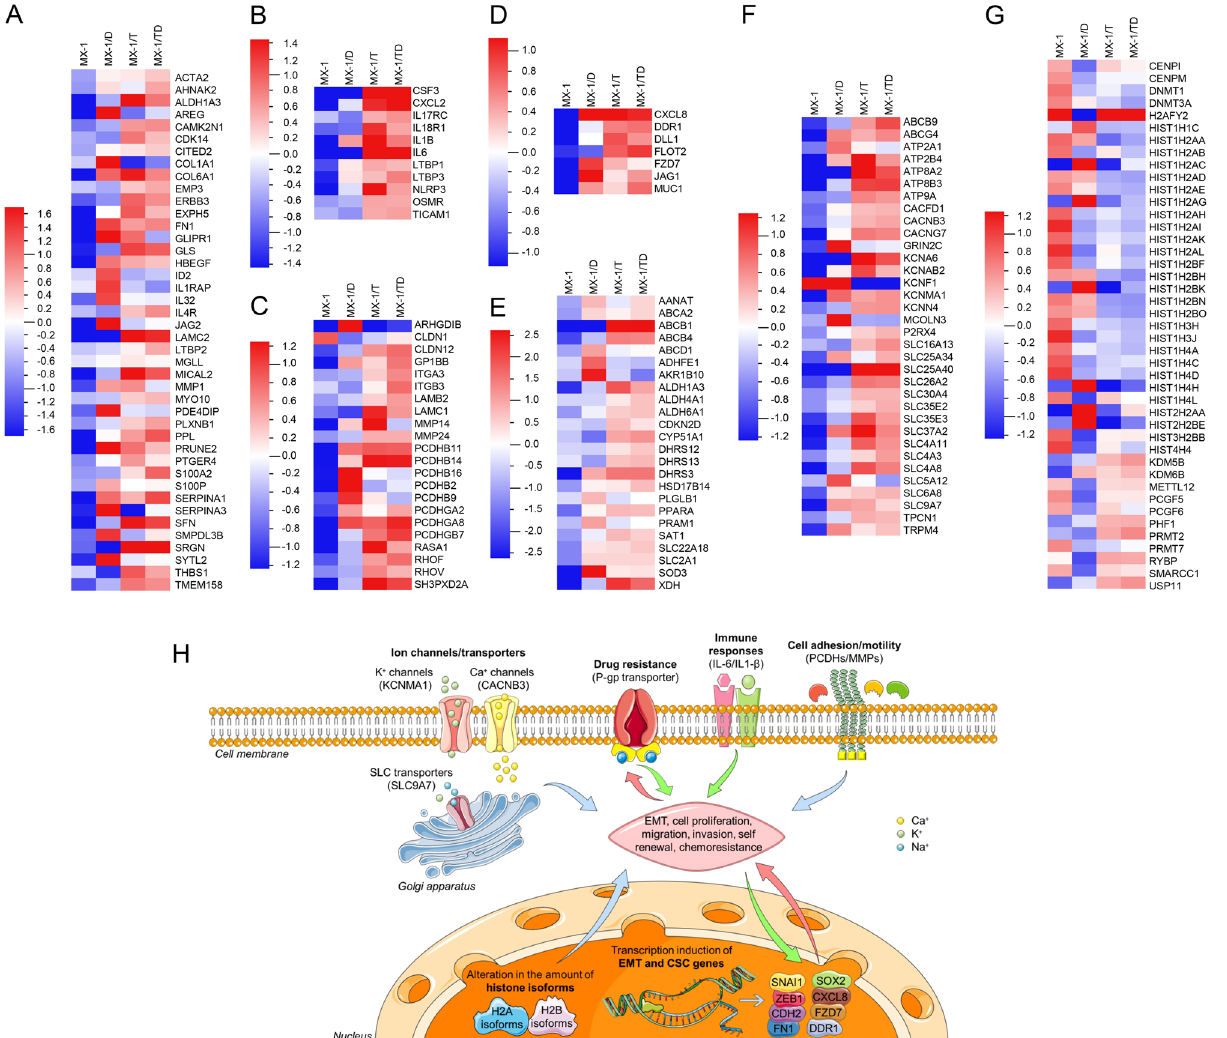
Figure 2. Cellular responses/pathways induced in chemoresistant MX-1 cell sublines. Heatmaps of differentially expressed genes (adjusted p < 0.05) from gene expression microarrays of chemoresistant MX-1 cell sublines: ( A ) epithelial–mesenchymal transition-related, ( B ) immune response-related, ( C ) cell adhesion and motility-related, ( D ) stem cells-related, ( E ) chemoresistance-related, ( F ) ion channels and ( G ) epigenetic regulators. The scale-bars indicate the normalized mRNA expression level, where the zero represents the mean expression level of the particular gene set. ( H ) The two hypothetical models of chemoresistance development were made according the human gene expression microarrays (Additional file 1, Table S1) and quantitative PCR results. The different coloring and directions of the arrows reflect the possibly different sequence of the activation of particular response pathway. In DOX-only exposed cells (red arrows) the deregulated expression of canonical EMT related genes and CSC markers was observed, what possibly caused cell migration and chemoresistance with an upregulated expression of drug metabolism-related enzymes (e.g. DOX metabolism- related AKR1B10 ) and later activation of ABCB1 mRNA expression. In TPP + -exposed cells (green arrows) marked activation of ABCB1 and immune response related genes were observed what supposedly caused cell migration, chemoresistance and possibly later activation of non-canonical EMT and CSC-related genes. The blue arrows indicate the pathways activated in both DOX-only and TPP + treated cells. This figure was created using images from Servier Medical Art Commons Attribution 3.0 Unported License (http:// smart. servi er. com). Servier Medical Art by Servier is licensed under a Creative Commons Attribution 3.0 Unported License. EMT epithelial–mesenchymal transition, CSC cancer stem cell, PCDHs protocadherins, MMPs matrix